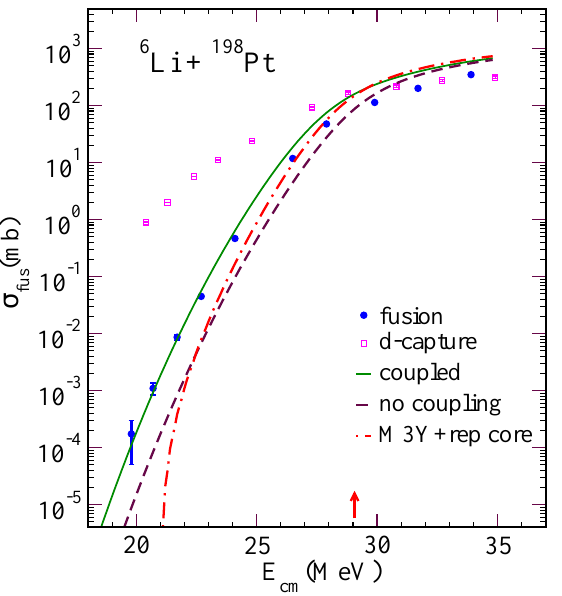
Fig. 1. (color on line) Cross-sections for compound-nuclear fu- sion and d-capture. The arrow indicates value of the Coulomb barrier (V B ). The results of the coupled-channels calculations us- ing the WS potential (solid line) along with single channel cal- culations using the WS potential (dashed line) and the M3Y po- tential with a repulsive core (dot-dashed lines) are shown (see the text).